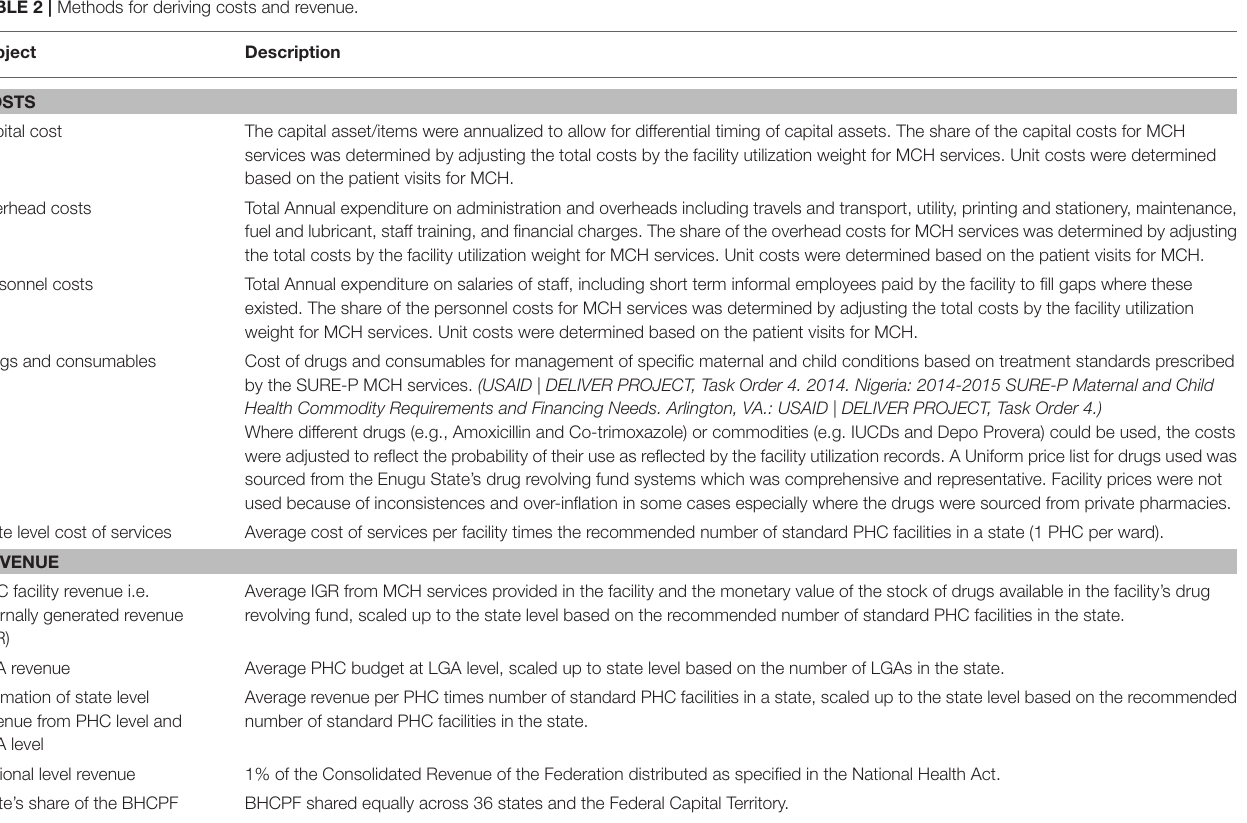
TABLE 2 | Methods for deriving costs and